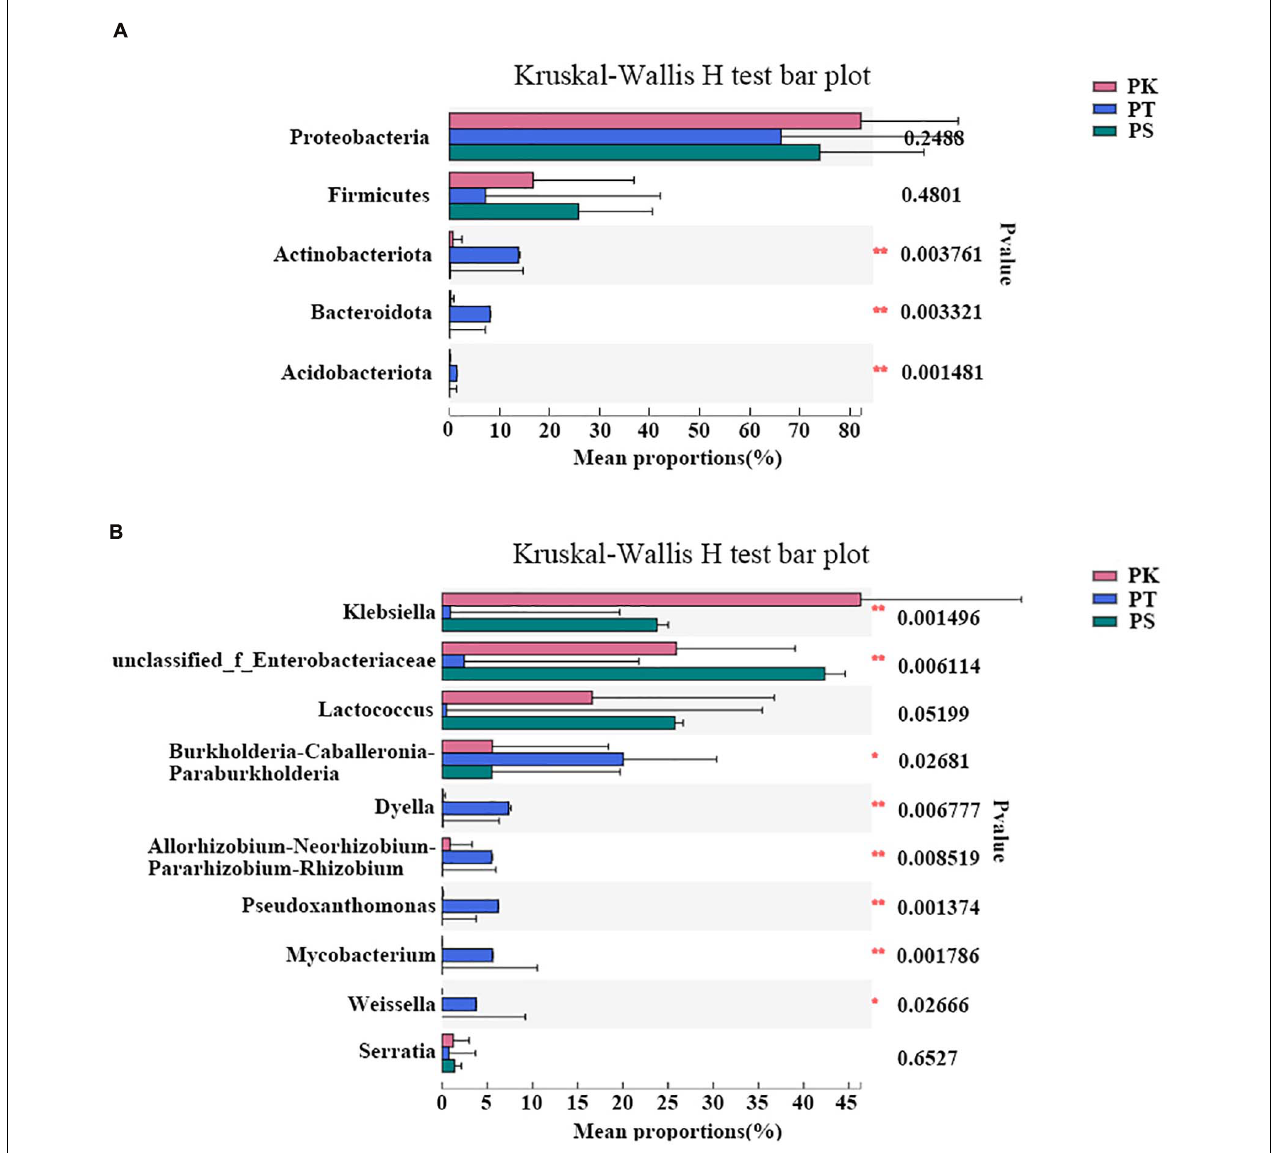
FIGURE 4 | Differences in intestinal bacteria of M. saltuarius feeding on different host tree species at the phylum and genus level. (A) Differences in abundance of dominant bacterial phyla (the top five are shown). (B) Differences in abundance of dominant bacterial genera (the top ten are shown) (Kruskal–Wallis H -test; * P < 0.05, ** P < 0.01, *** P <